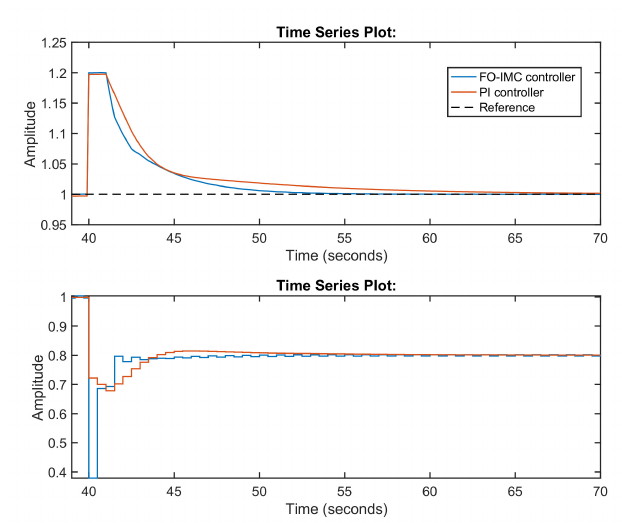
Figure 7. Comparisonbetweentheclosedloopsystemswiththeevent-basedFO-IMCandthePIcontrollers for a 0.2 disturbance rejection (output signal in the upper plot, input signal in the lower plot).